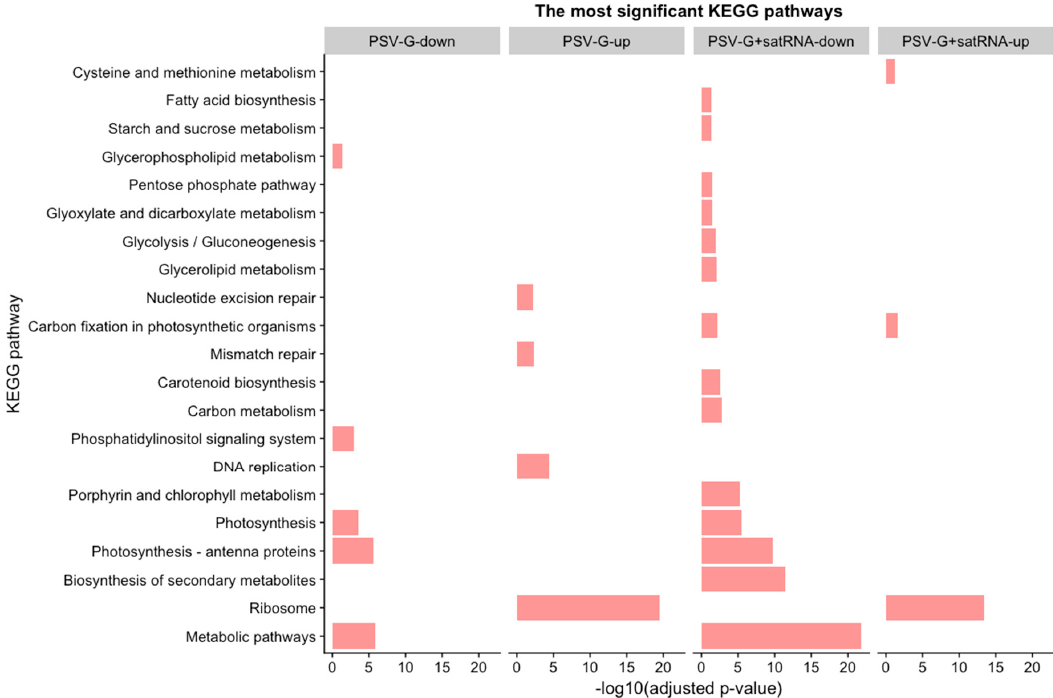
Figure 8. A subset of affected KEGG pathways involving up-regulated and down-regulated DEGs in plants infected with PSV or PSV + satRNA. The significant KEGG pathway terms for up- and down- differentially regulated genes were assigned to the y-axis and the negative logarithm of the adjusted p -value to the x-axis (the longer the more significant). Only the significant terms are shown and the bars are ordered based on their significance (seen from below).